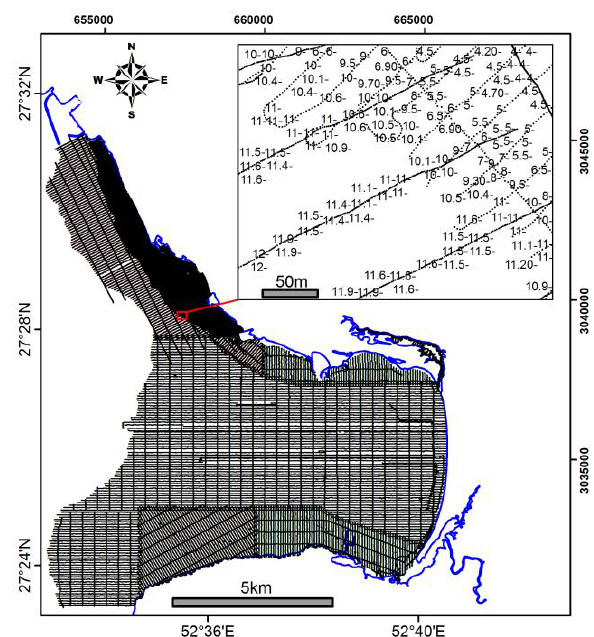
Figure 2. Original sounding points surveyed using single beam echo-sounder by the National Cartographic Centre of Iran. The density of points is higher in areas with rough topography and lower in smooth topography areas